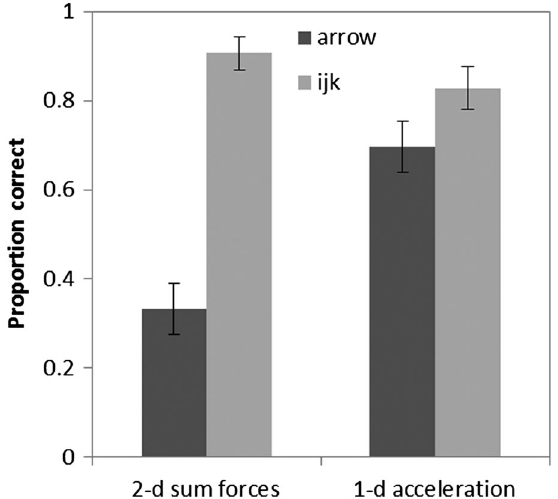
FIG. 8. Student performance ( N ¼ 130 ) on two-dimensional (Fig. 6) and one-dimensional (Fig. 7) physics context questions in both the arrow (grid) and ijk formats. Error bars indicate (cid:2) 1